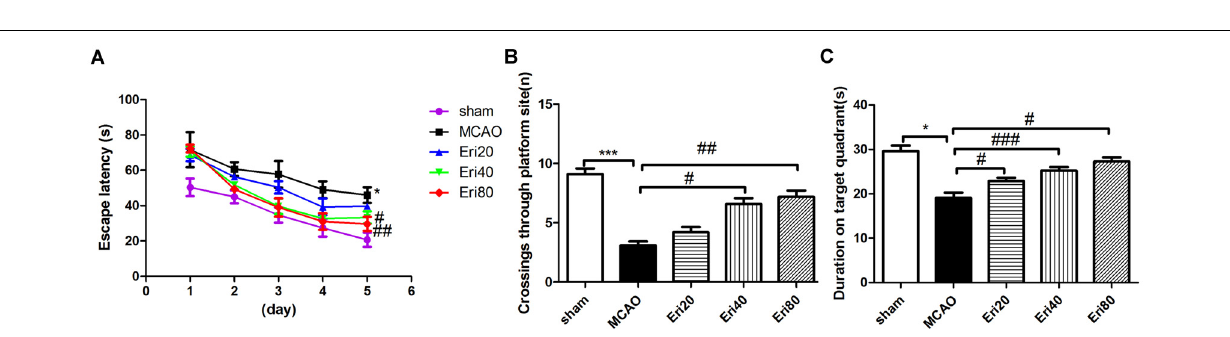
FIGURE 2 | Performance of rats in Morris water maze test. (A) The average latencies in sham group, MCAO group, Eri20 group (MCAO+Eri20 mg/kg), Eri40 group (MCAO+Eri40 mg/kg) and Eri80 group (MCAO+Eri80 mg/kg) within 5 days and the mean passes through the target platform (B) . (C) Mean percentage time in the target guardant during probe trial (The data are presented as mean ± SEM, n = 15 each group, * P < 0.05, *** P < 0.001, vs. sham group; # P < 0.05, ## P < 0.01, ### P < 0.001, vs. MCAO